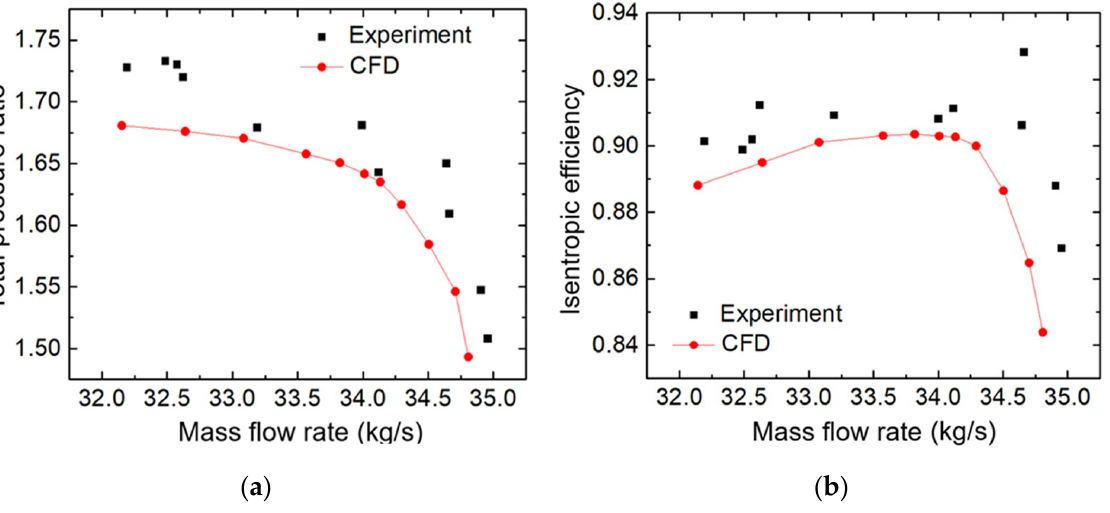
Figure 4. Comparison of performance curves. ( a ) Total pressure ratio. ( b ) Isentropic efficiency.